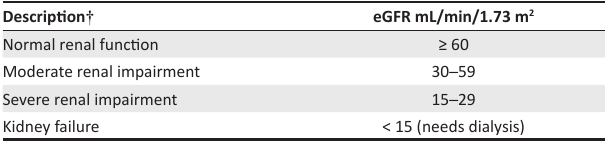
TABLE 1: Staging of chronic kidney